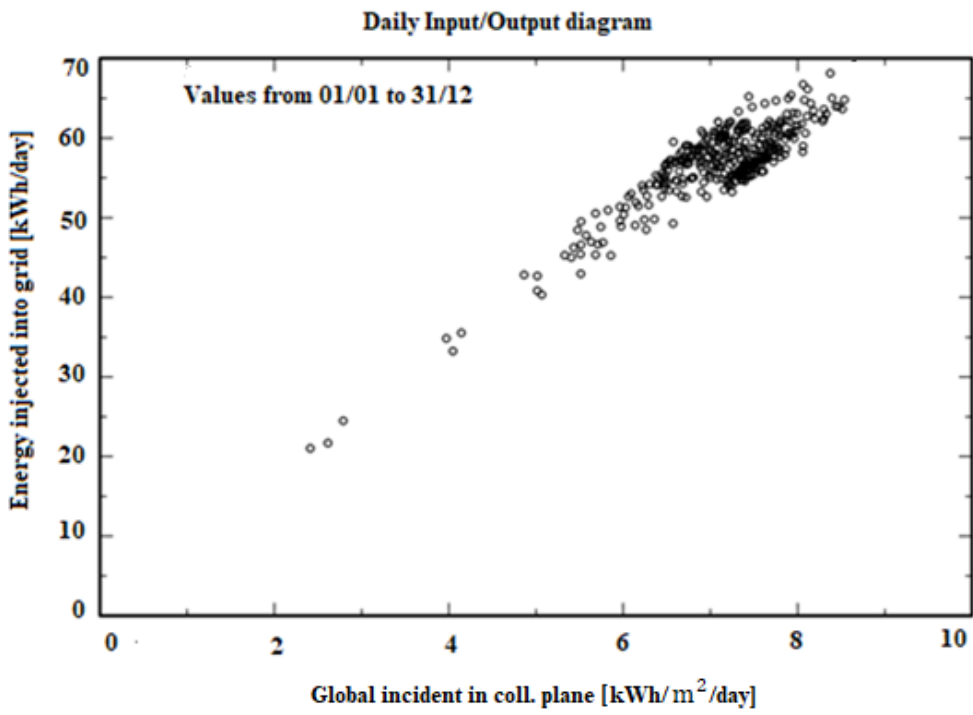
Figure 8. System output power distribution for the Darab area.